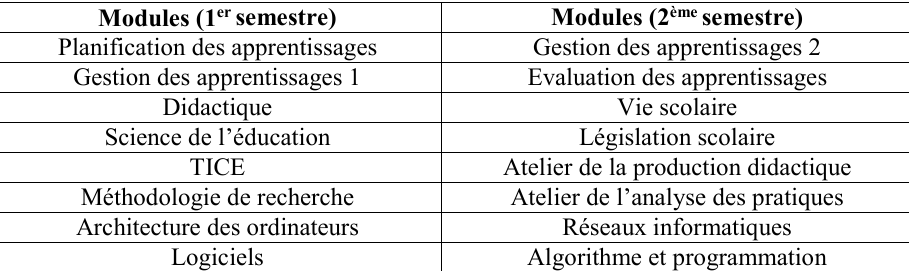
Tableau 1. Programme de formation des enseignants